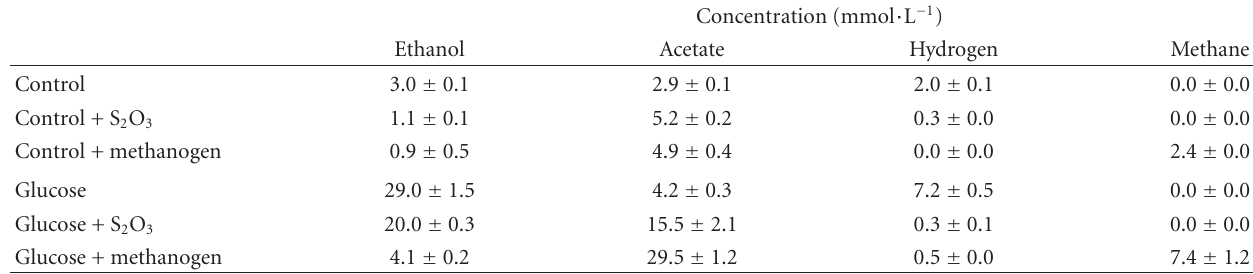
Table 1: Utilization of glucose by strain J1 in the presence of thiosulfate or a hydrogenotrophic methanogen. Data represents average of two replicate experiments ± standard